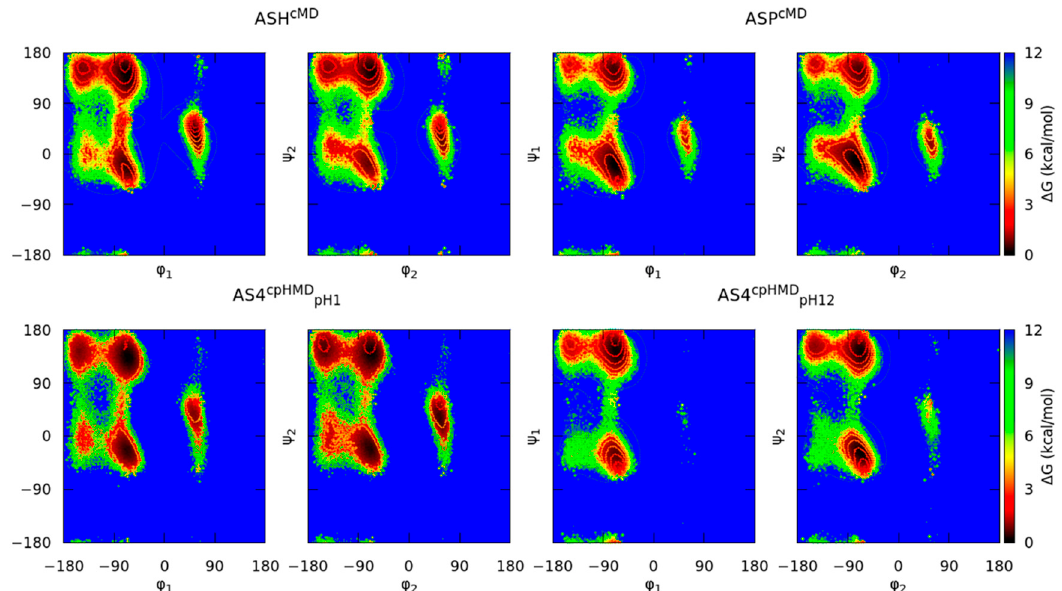
Figure 2. Ramachandran maps of the capped Asp 2 tripeptide. Titles indicate the residues, the simulation method in the superscripts, and the pH value in the subscripts. Each simulation condition has two energy maps according to the set of backbone dihedral angles of the N-terminal ( ϕ 1 / ψ 1 ) or the C-terminal amino acid ( ϕ 2 / ψ 2 ). Solid lines indicate an increase of 0.6 kcal/mol in the energy map.